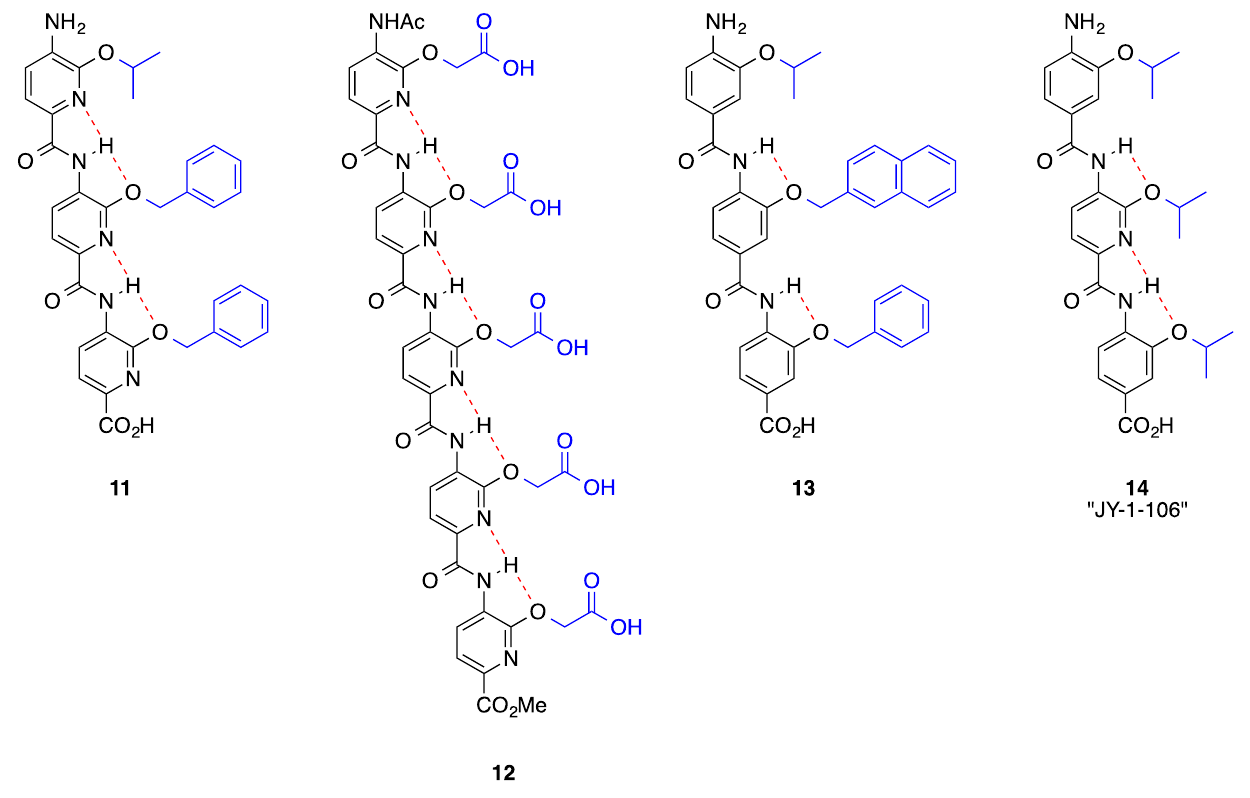
Figure 4. Oligoarylamides as single-faced helix